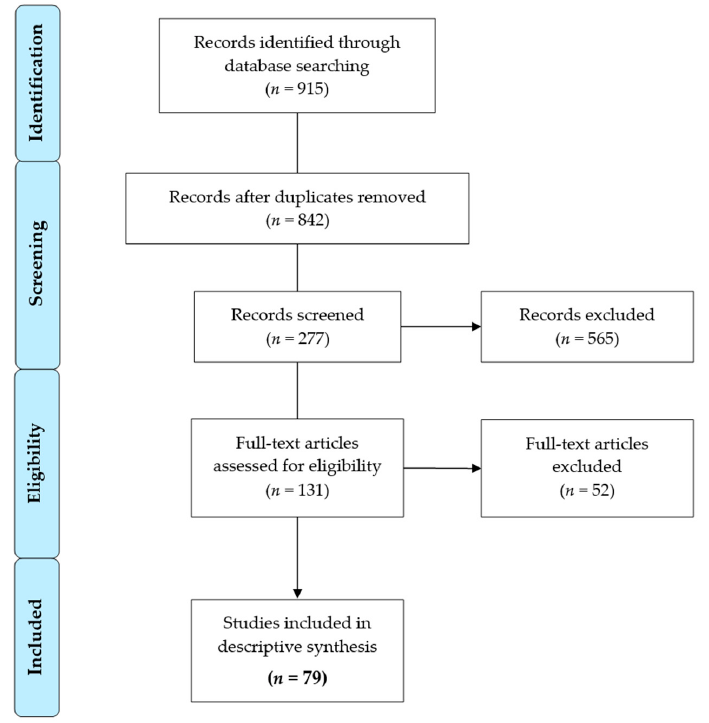
Figure 1. Flow diagram displaying study screening, eligibility and inclusion. Table 1. Summary of the most-used single markers of frailty found to be predictive or not predictive (number of studies and (total patients)) of mortality risk over the short term ( ≤ 30 days), intermediate term (> 30 days to < 1 year) and long term ( ≥ 1 year).